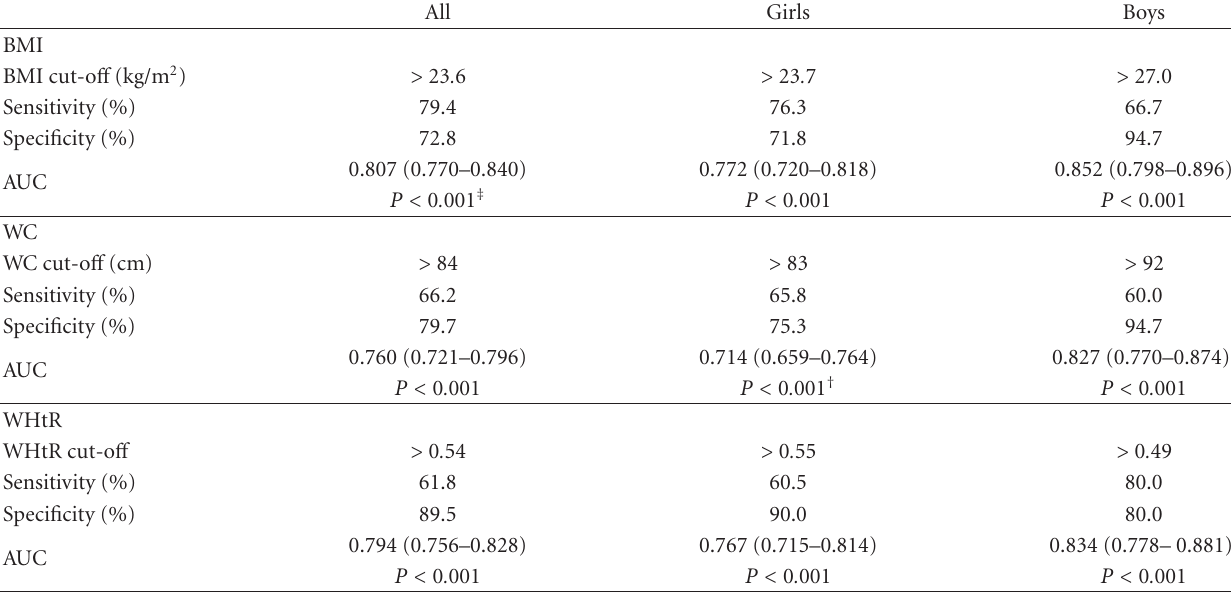
Table 2: Cut-o ff values, sensitivity, and specificity for the association of di ff erent measures of adiposity with metabolic risk score by sex. All Girls